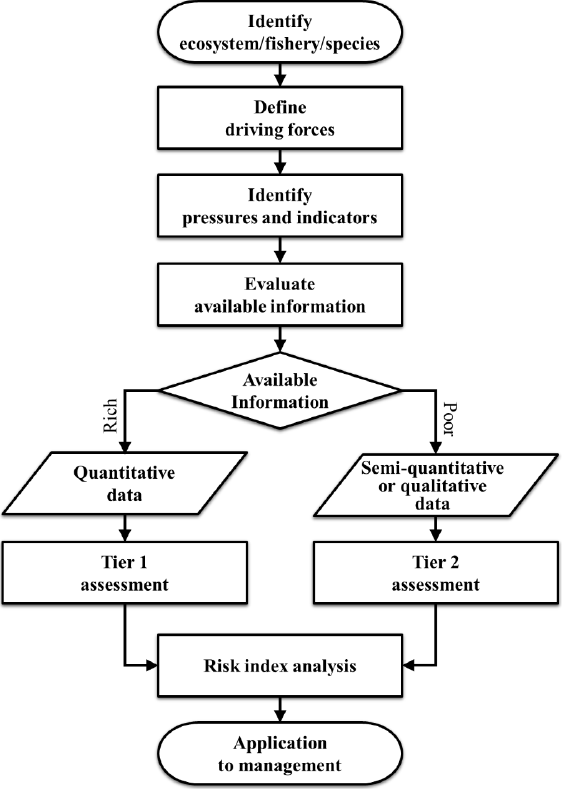
Figure 2. A process flow chart illustrating the extended ecosystem-based fisheries assessment